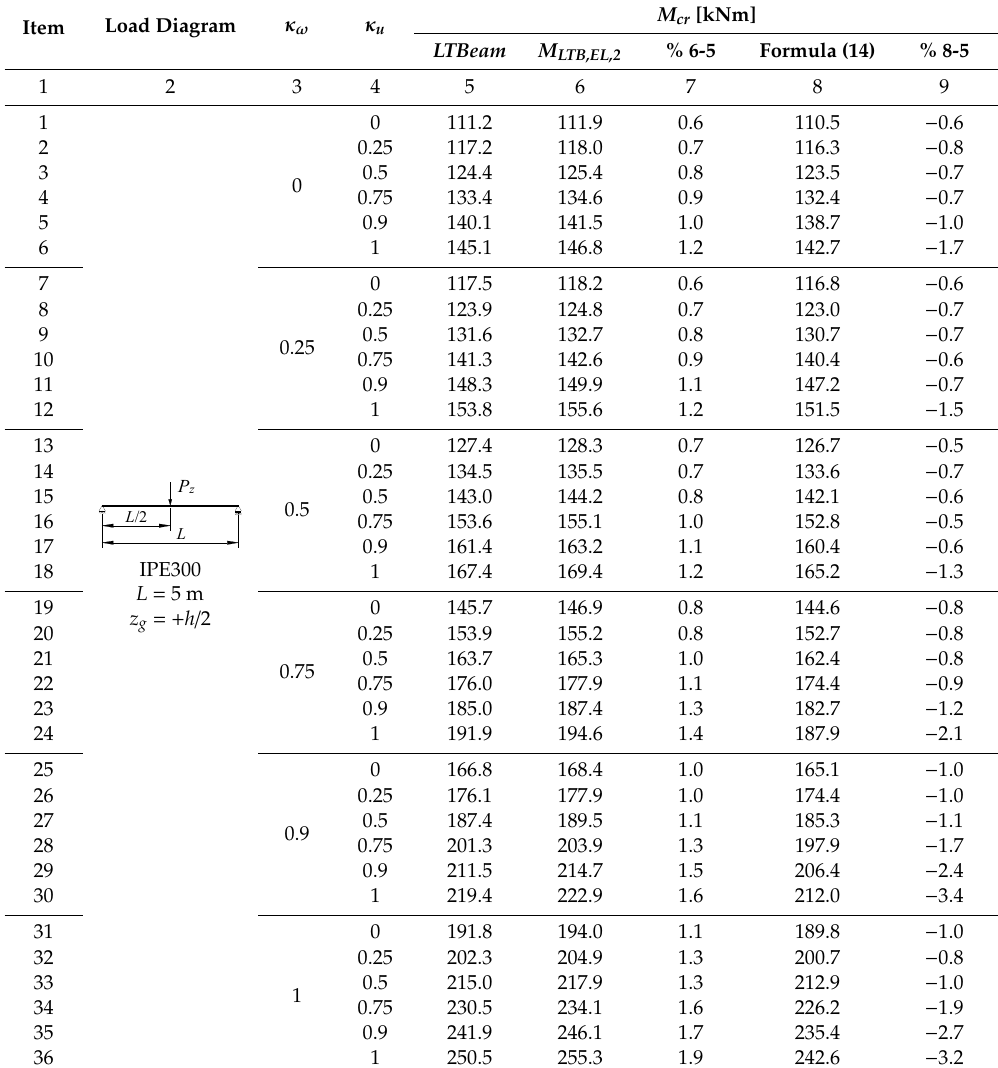
Table 4 lists exemplary results of calculations obtained for IPE300 beam, with a span of L = 5 m, loaded with a concentrated force applied to the upper flange ( z g = + h /2) at the midspan. Percentage Table 4. Comparison of M cr for beam IPE300 ( L = 5 m). differences in the results obtained with M LTB,EL,2 programme (Column 6) relative to the LTBeam programme (Column 5) are shown in Column 7. Analogous comparison of the results obtained with Formula (14) (Column 8) and the LTBeam programme (Column 5) can be seen in Column 9.